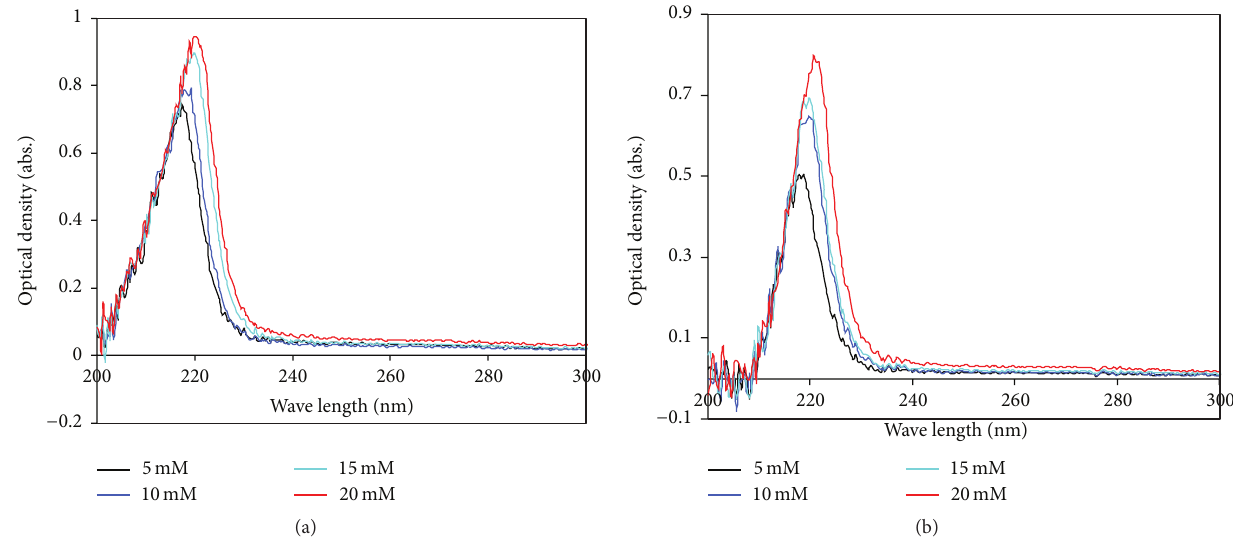
Figure 2: UV-visible spectra of four standard TBAB solutions: (a) in pH 7 aqueous solutions; (b) in pH 11 aqueous solutions.